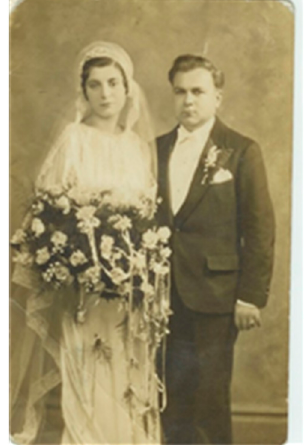
Figure 12. Mitsos’ and Maria’s wedding photo (courtesy of Victoria P).